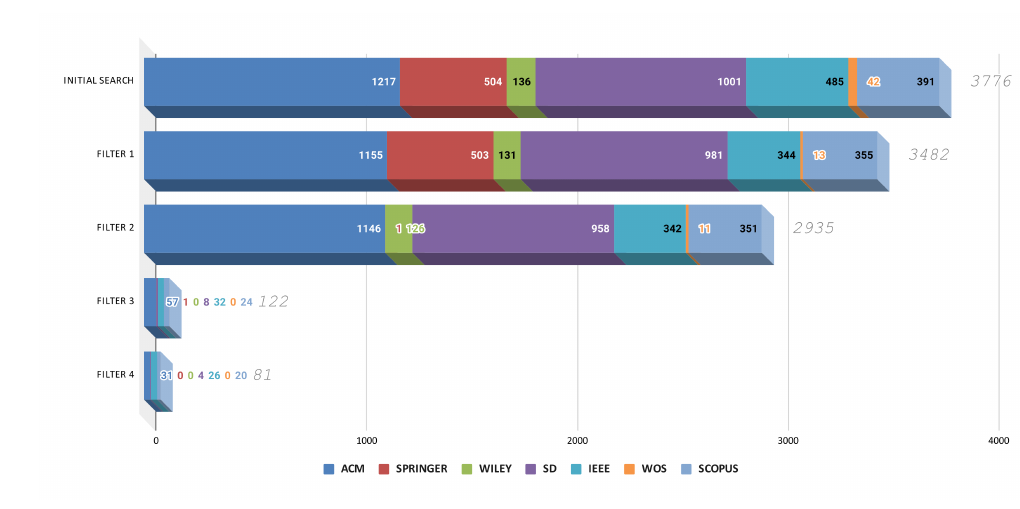
Figure 6. Distribution of results by data source.